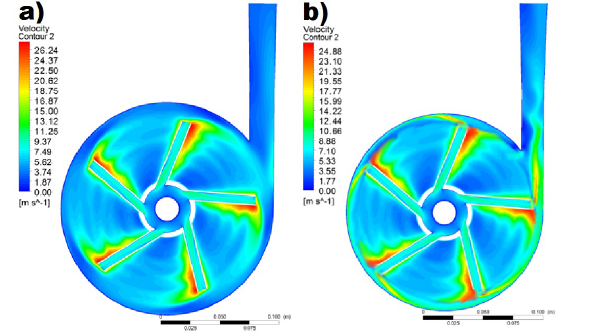
Figure 11: Distribution of liquid velocity on central plane (SPAN50) for: a) base model pump, b) pump with rational flow geometry of annular casing.